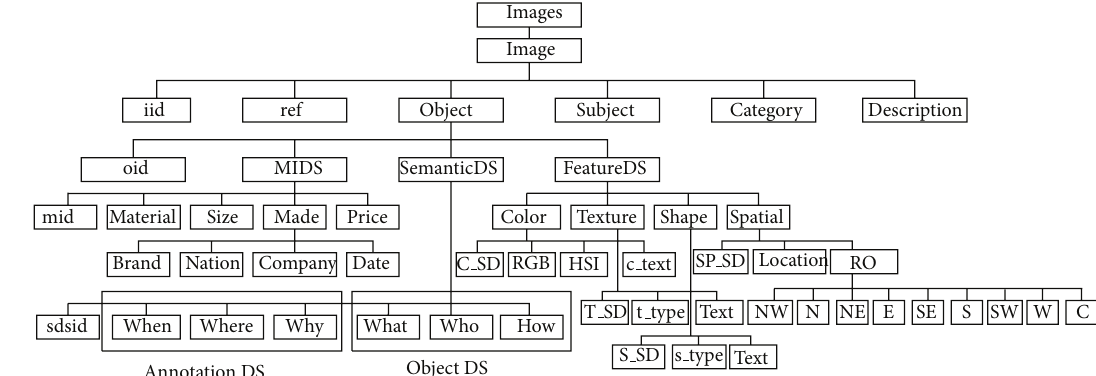
Figure 6: XML DTD structure.